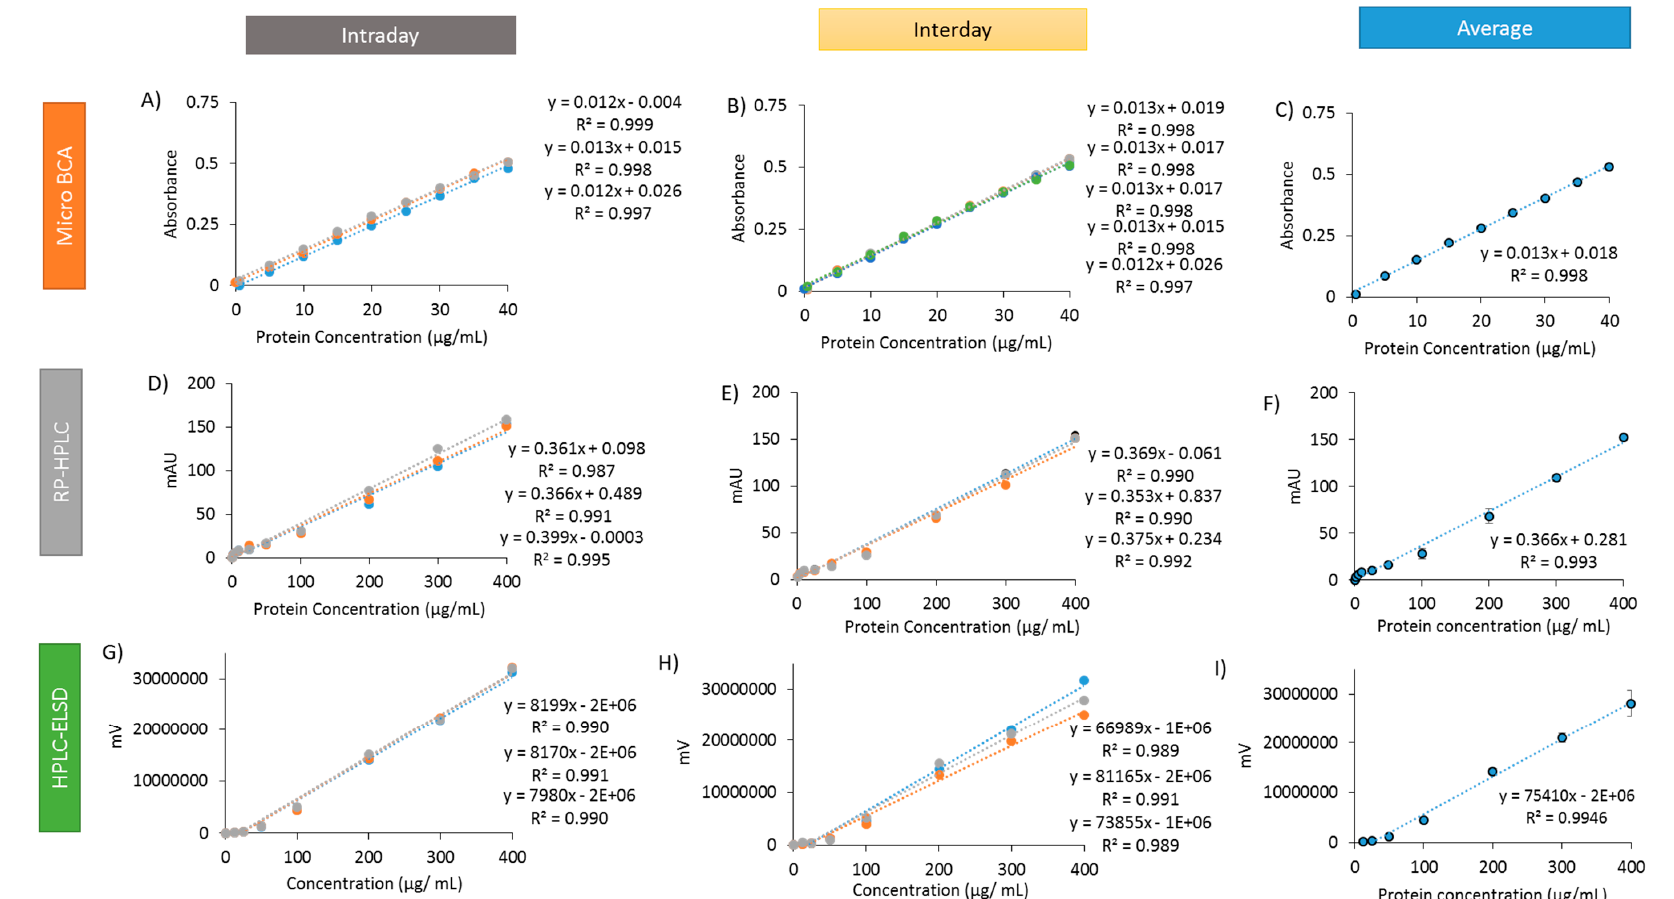
Figure 1. Ovalbumin calibration curves for three quantification techniques. The calibration curves for micro BCA ( A – C ) include: Intraday curves ( A ), Interday curves (generated over 5 separate days) ( B ), alongside the average ( C ). Calibration curves were also generated for RP-ELSD ( D – F ), including: Intraday curves ( D ), Interday curves (generated over 3 separate days) ( E ), as well as the average ( F ). The same was also generated for the HPLC-ELSD ( G – I ): Intraday curves ( G ), Interday curves ( H ), and the average ( I ). Results represent the average of at least three replicate measurements ± standard deviation (SD).